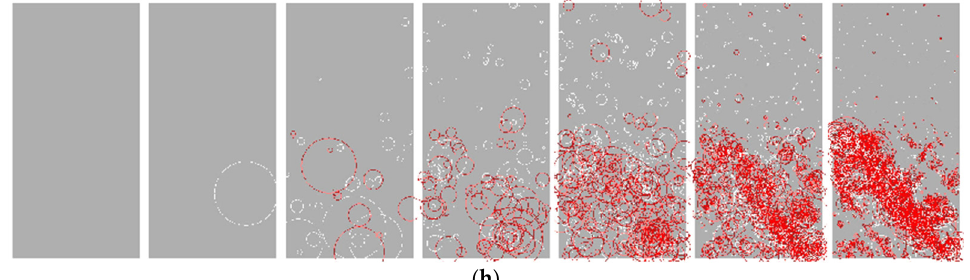
Figure 9. Acoustic emission evolution behaviors of coal–rock combined body: ( a ) θ = 0°; ( b ) θ = 15°; ( c ) θ = 30°; ( d ) θ = 45°; ( e ) θ = 60°; ( f ) θ = 75°; ( g ) θ = 90°; ( h ) intact specimens.